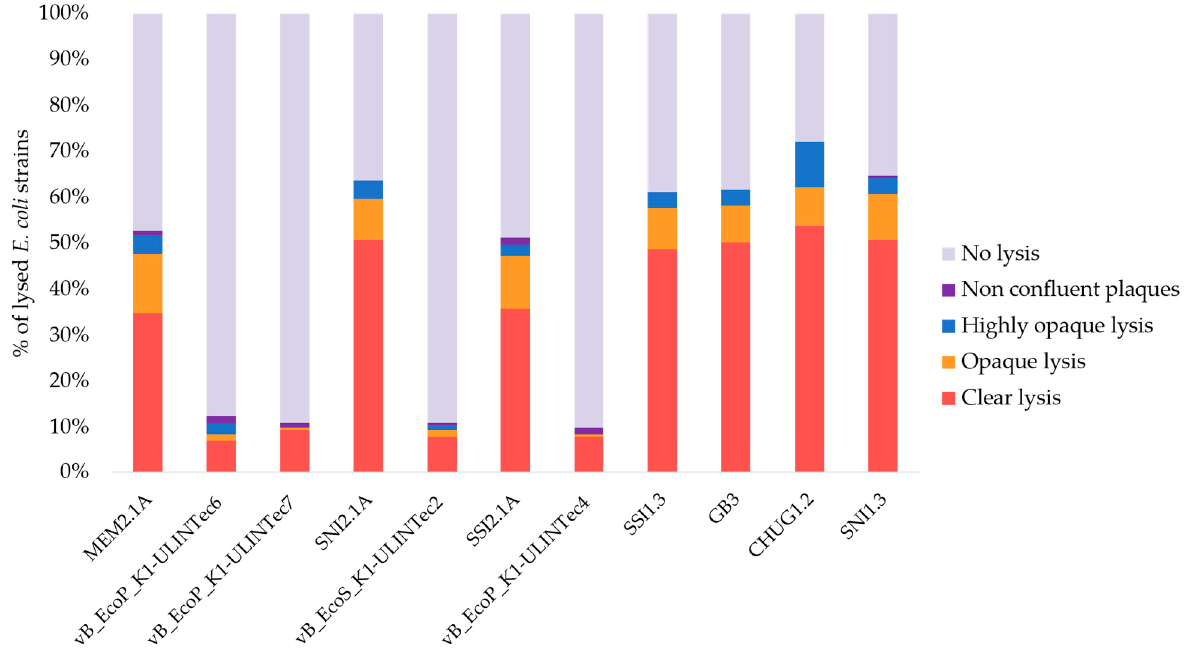
Figure 3. Percentage of lysed strains and degree of lysis of the 11 phages isolated against E. coli O18:K1.